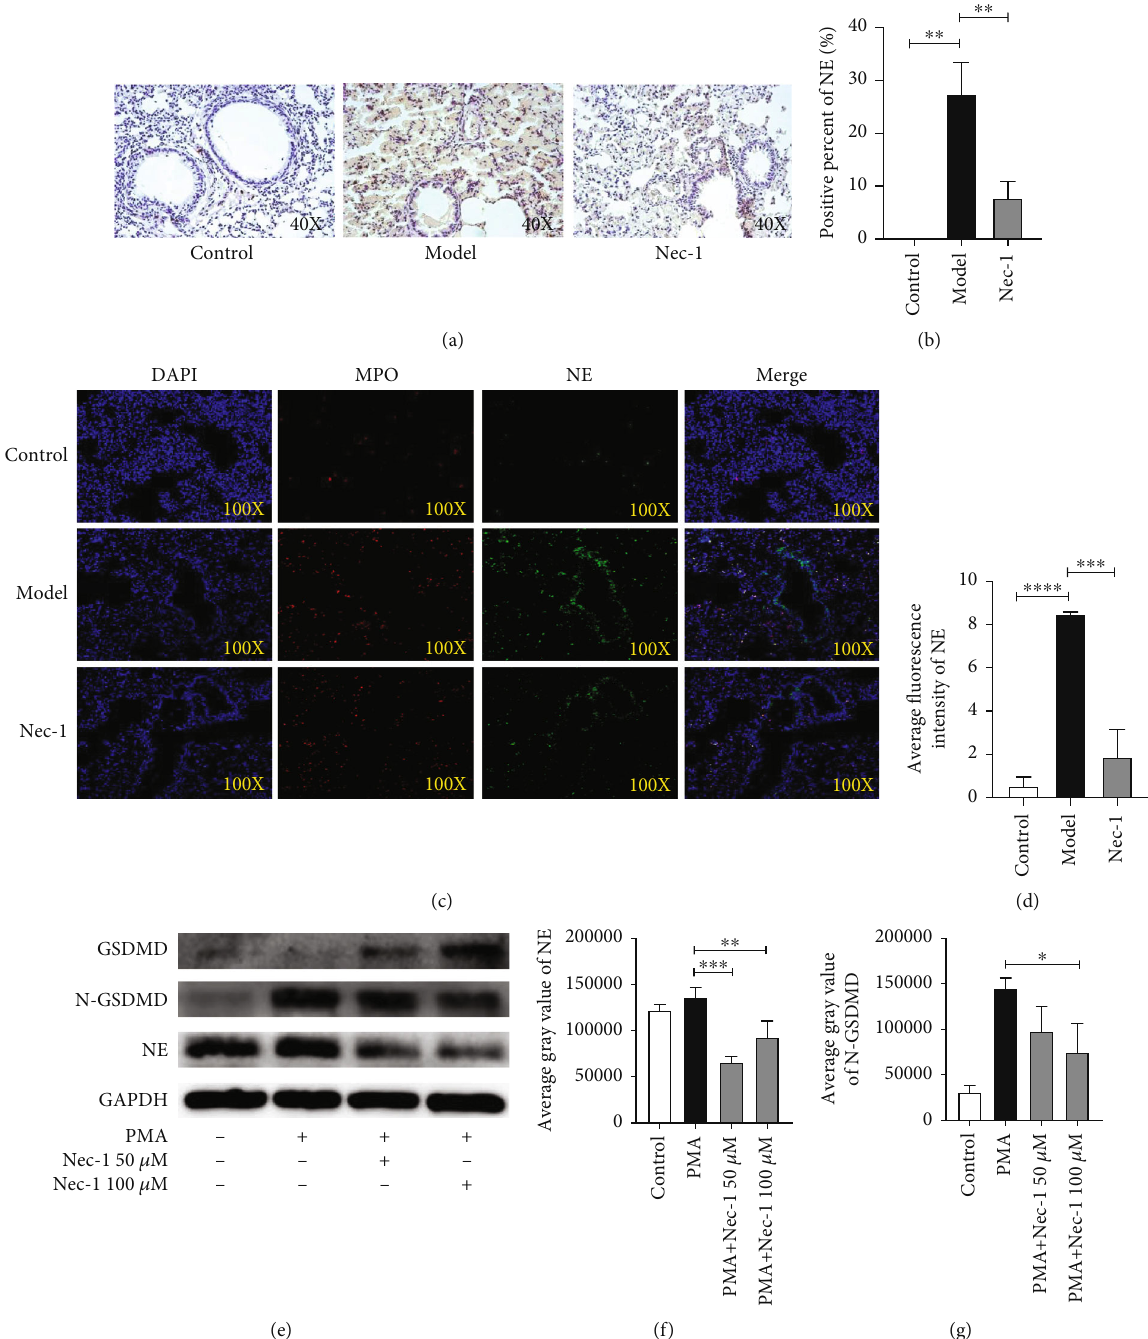
Figure 5: Nec-1 prevents the release of neutrophil extracellular traps (NETs) by inhibiting neutrophil elastase (NE). (a) Representative images of the immunohistochemistry of NE in di ff erent groups. The sepia areas indicate active NE cells. (b) NE-positive rate of immunohistochemistry in di ff erent groups was calculated using ImageJ. (c) Representative immuno fl uorescence images of the nucleus, NE, and MPO in the lung tissues of di ff erent groups. Nuclei were stained by DAPI (blue), whereas MPO and NE were stained with antibody immuno fl uorescence separately. (d) The average fl uorescence intensity of NE in di ff erent groups was calculated using ImageJ. (e) Representative western blot images of Gasdermin D (GSDMD), N-Gasdermin D (N-GSDMD), NE, and glyceraldehyde-3-phosphate dehydrogenase (GAPDH) in di ff erent groups. (f) The average grey value of protein NE in di ff erent groups was calculated using ImageJ. (g) The average grey value of protein N-GSDMD in di ff erent groups was calculated using ImageJ. Data are presented as mean ± standard deviation. Values were expressed as mean ± standard error of the mean of three independent experiments ( ∗ P < 0 : 05 , ∗∗ P < 0 : 01 , ∗∗∗ P < 0 : 001 , and ∗∗∗∗ P < 0 : 0001